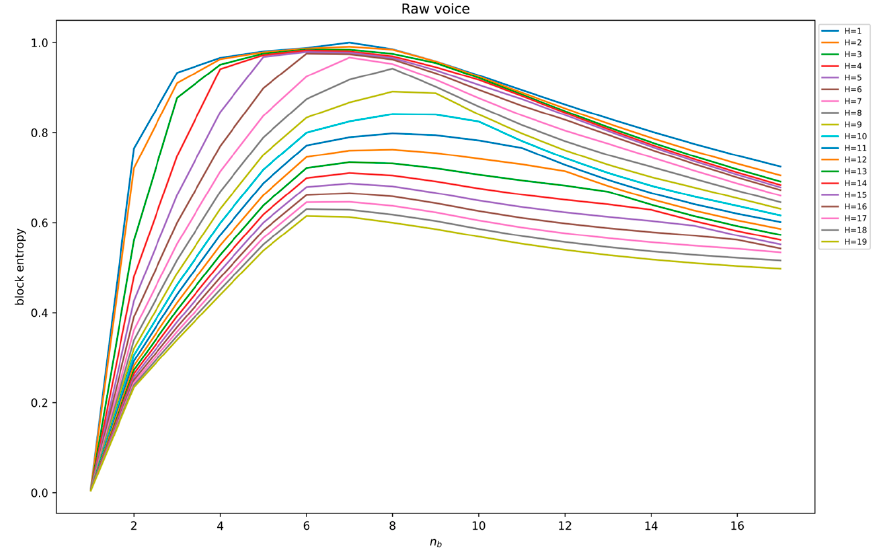
Figure 5. Relationship between block entropy rate and the number of bits n b per sample of the voice signal for the range of block values from 1 to 20. Different block length values are represented by distinct curves.